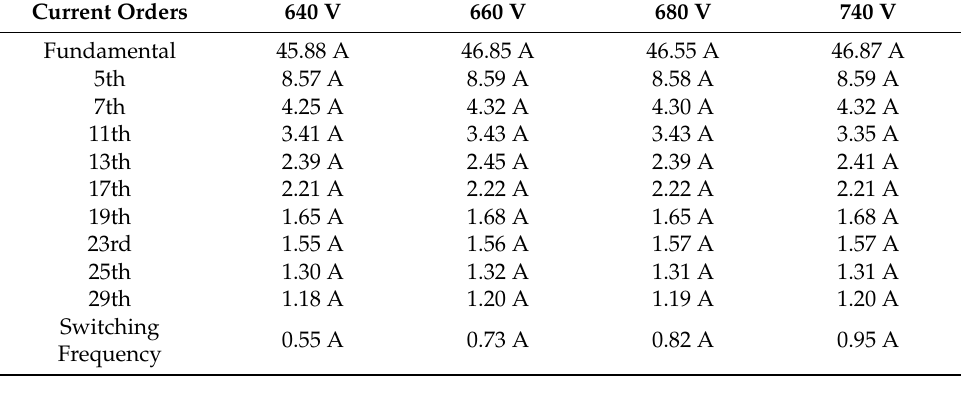
Table 4. The values of compensating current in each order with varied DC-link voltages.